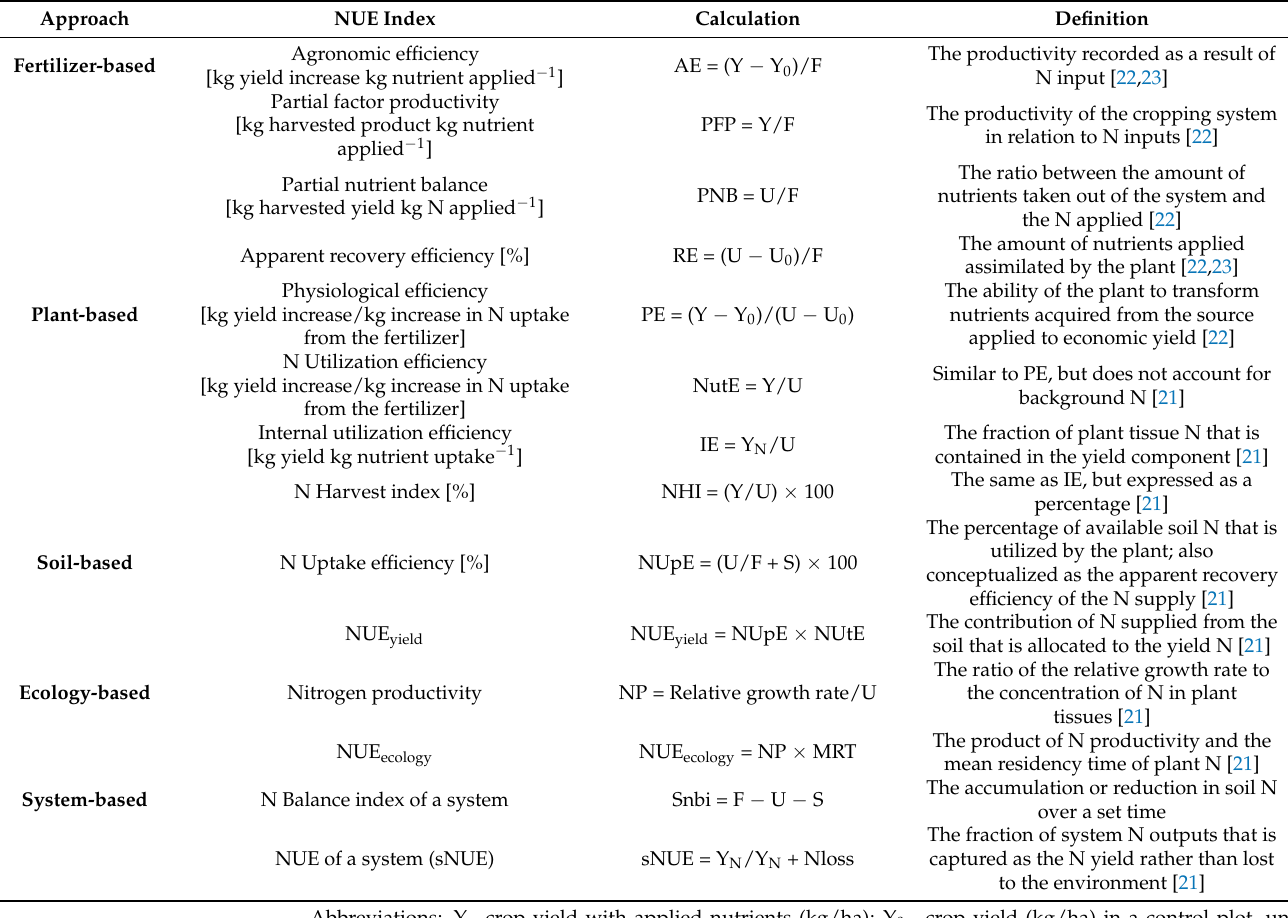
Table 1. NUE indices and their